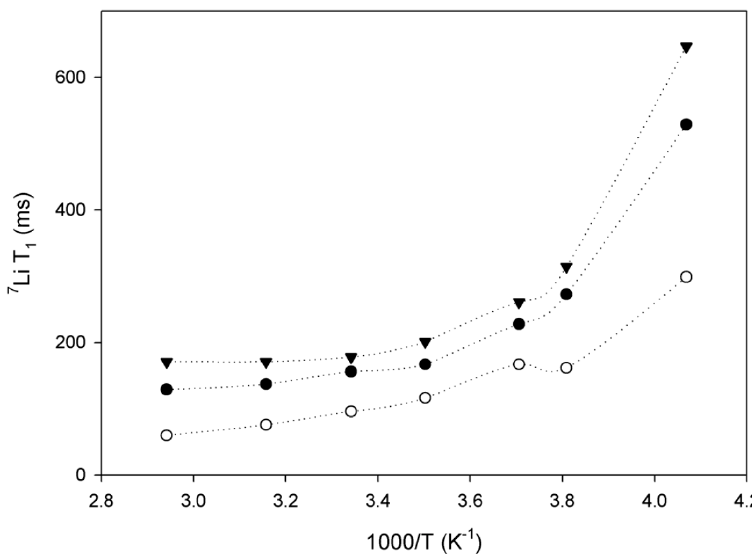
Figure 4. Evolution of 7 Li linewidth as a function of inverse temperature for sample 1 ( black triangles ), sample 2 ( open circles ) and sample 3 ( black circles ) [60] (OPEN ACCESS).